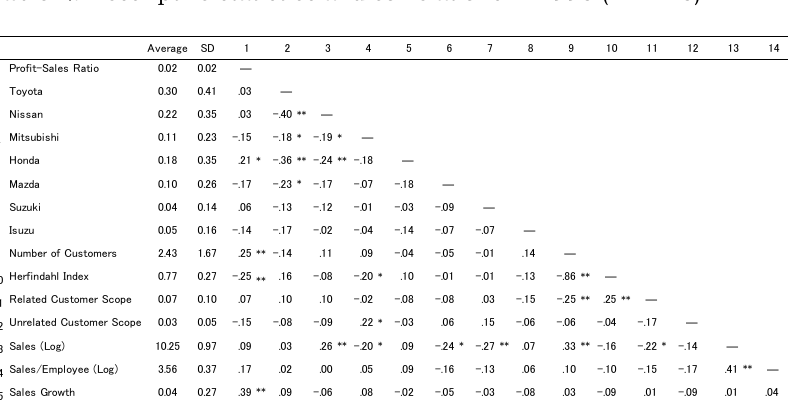
Table 2. Descriptive statistics and correlations in 1995 ( N = 115)